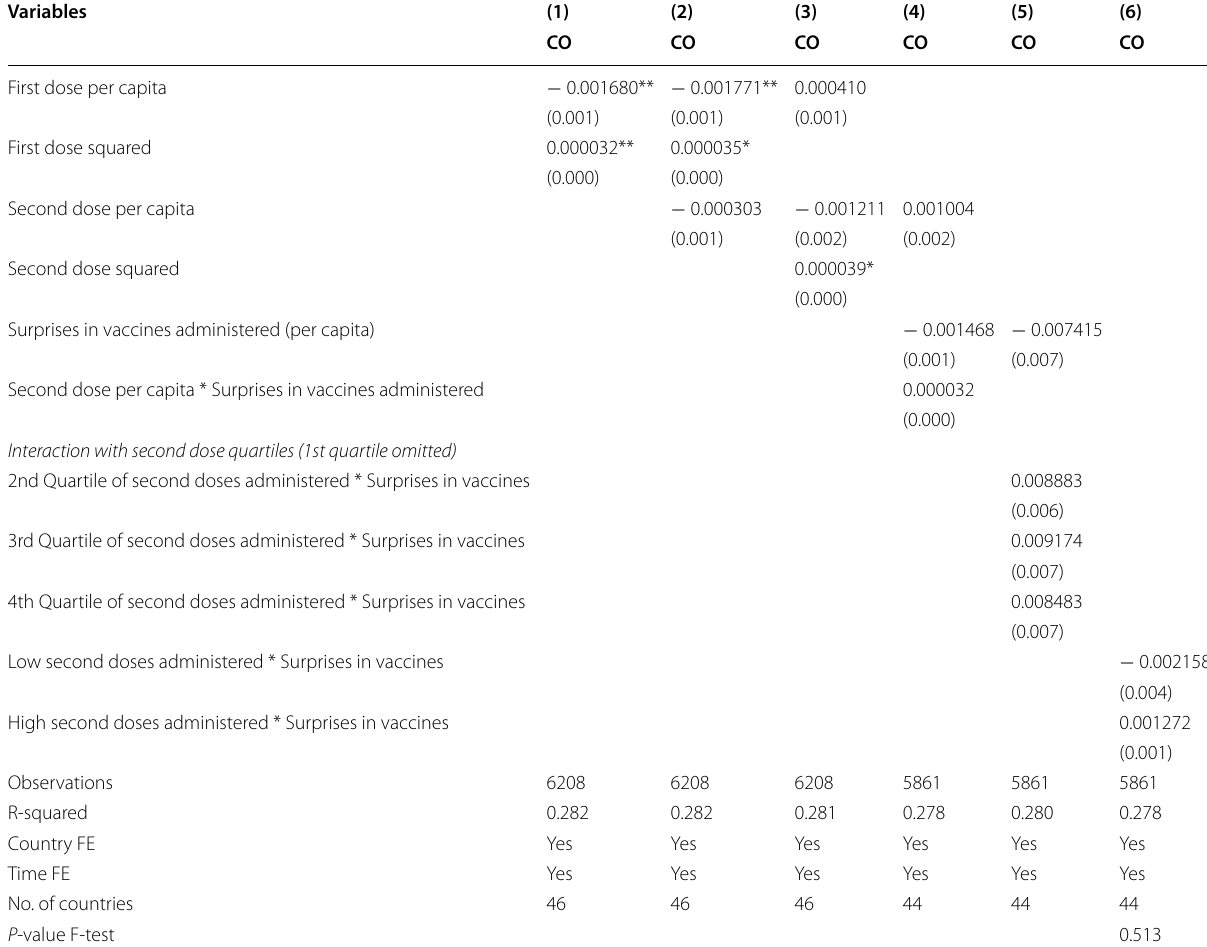
Table 11 Nonlinear effects of vaccines on economic activity using